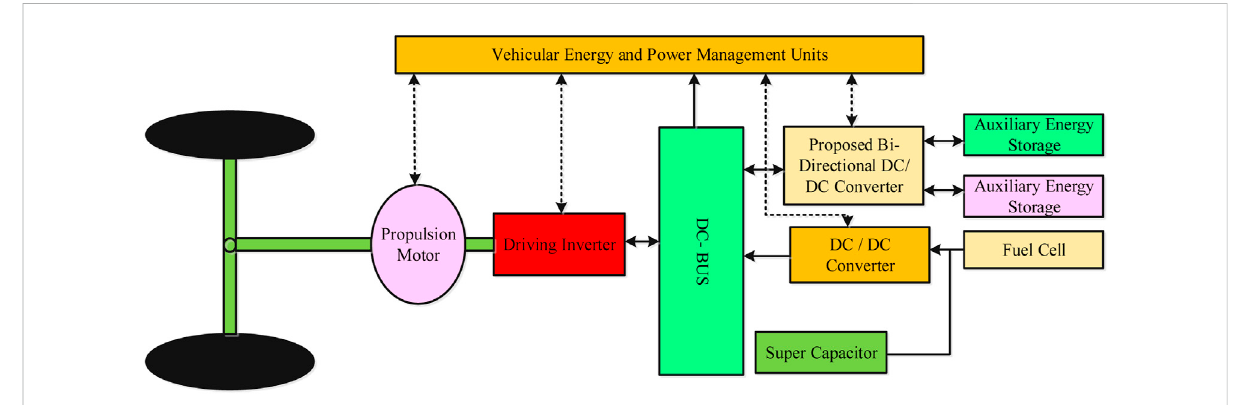
FIGURE 1 Schematic structure for an FCV/HEV power